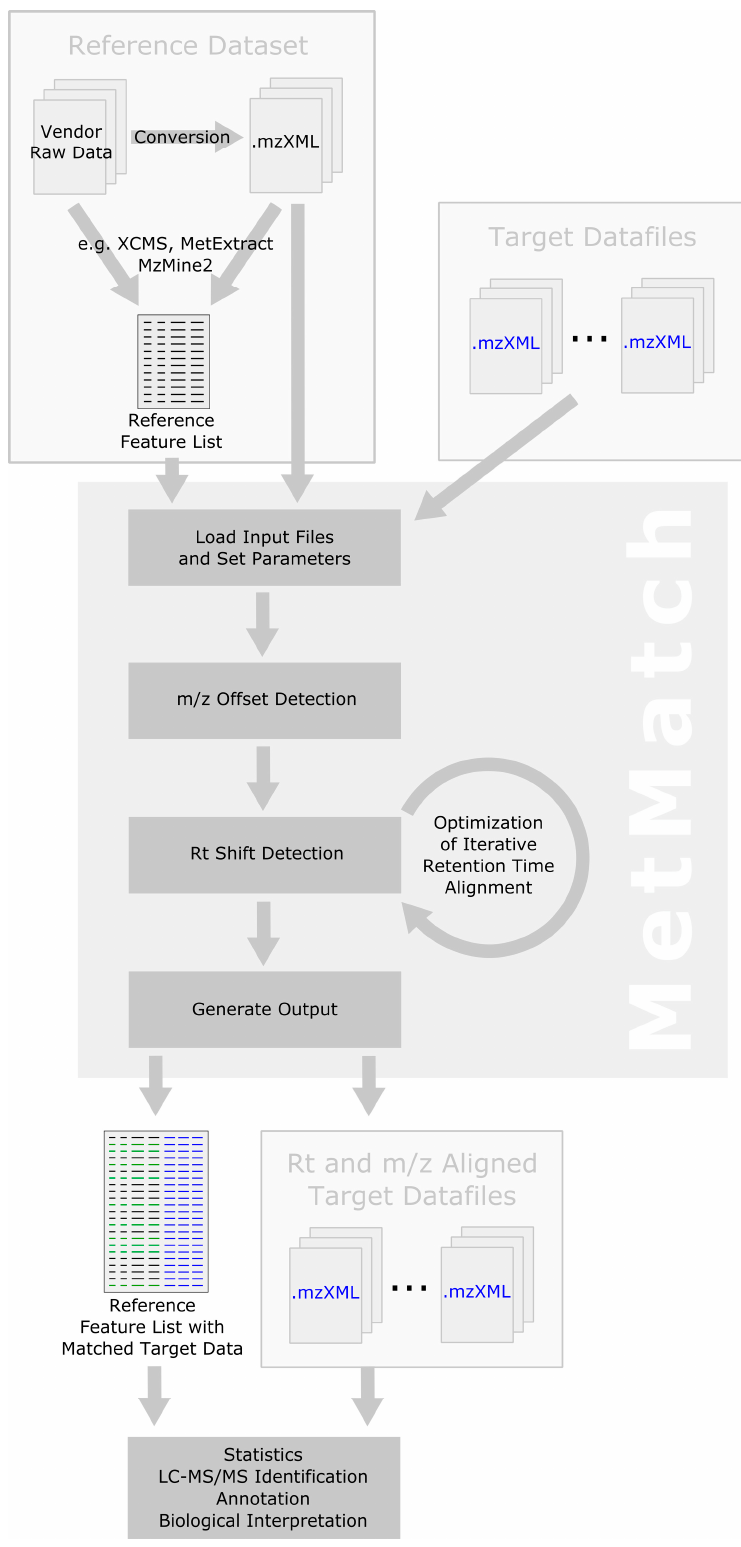
Figure 5. Schematic data processing workflow illustrating how MetMatch can be integrated into existing analysis pipelines.